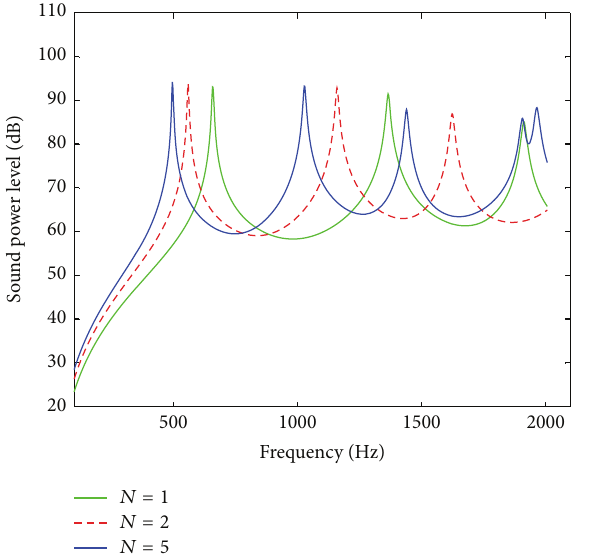
Figure 8: The effect of graded Young’s modulus through thickness on sound radiation of FGM plates.